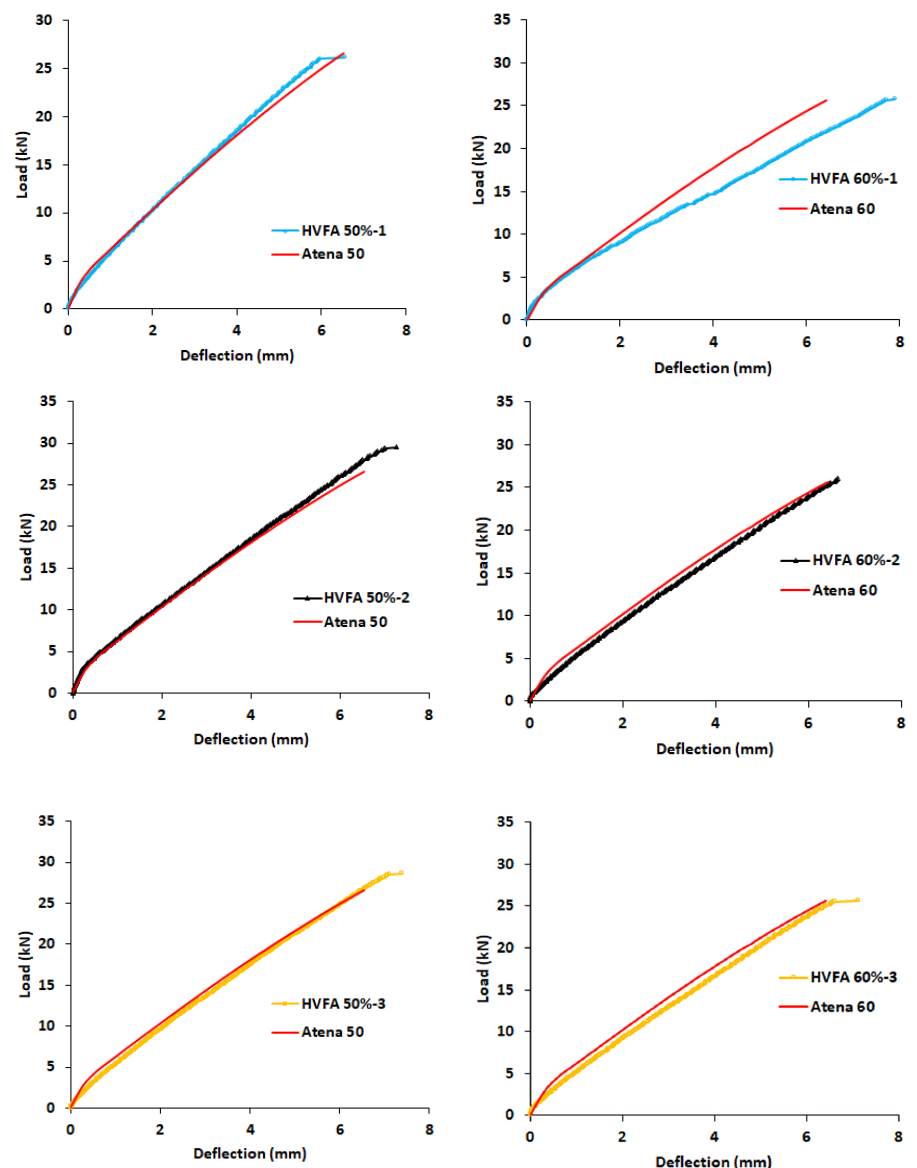
Figure 10. Comparison of load-deflection curves determined by experiments and numerical simulation. Table 6. Comparison of measured and predicted shear strength and deflection.